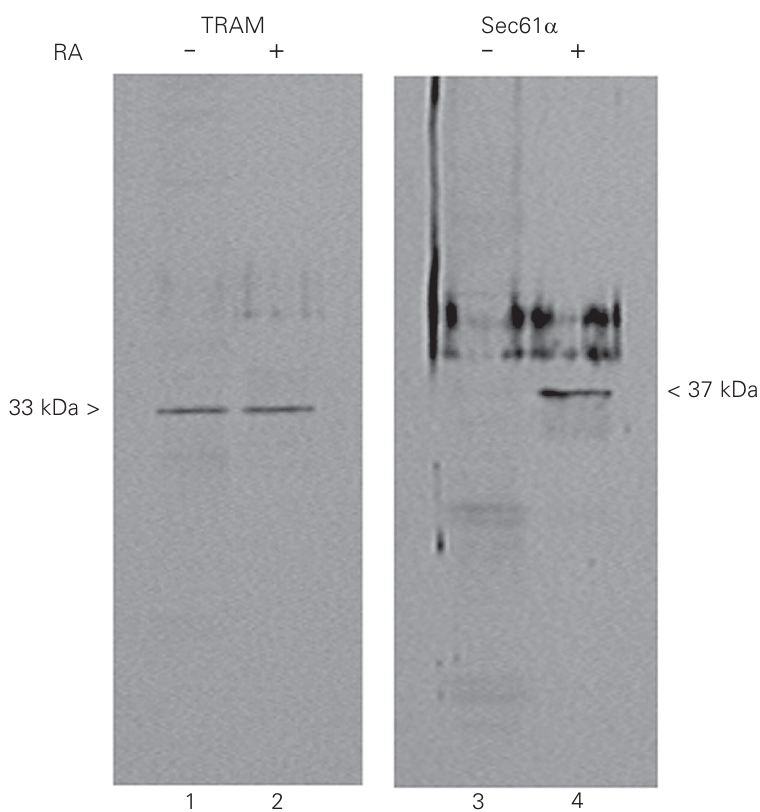
Figure 3 - Distribution of translocating chain-associating membrane protein (TRAM) and Sec61 (cid:1) using the Western blotting technique with enhanced chemiluminescence following retinoic acid (RA) treatment. F9 cells were incubated at 37 (cid:1) C with (lanes 2 and 4) or without (lanes 1 and 3) retinoic acid for 4 days. Antibodies against TRAM (lanes 1 and 2) and Sec61 (cid:1) (lanes 3 and 4) were applied and the nitrocellulose paper was then exposed to radiographic film.